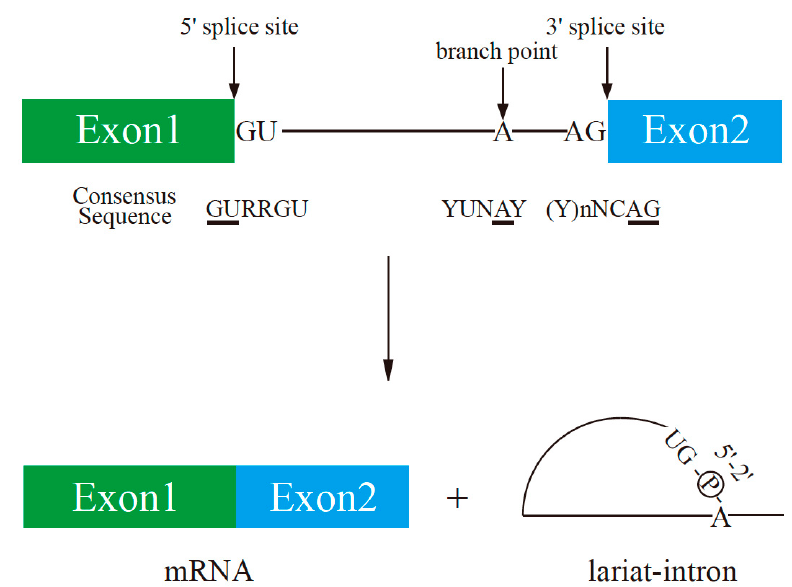
Schematic representation of the splicing reaction and essential splicing signals. Conserved sequence elements of metazoan pre-mRNAs are indicated. R and Y stand for purine and pyrimidine residues, respectively. N indicates any nucleotide. The adenosine residue used as a branch nucleotide is underlined.